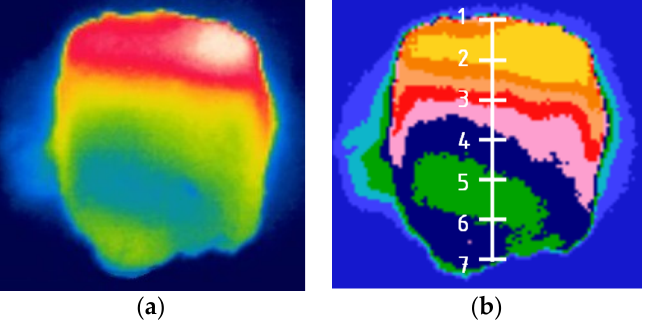
Figure 8. Thermogram: ( a ) unprocessed, ( b ) processed in FLIR Quick Report with measuring points where temperature readings were taken to prepare the temperature distribution on the briquette surfaces .